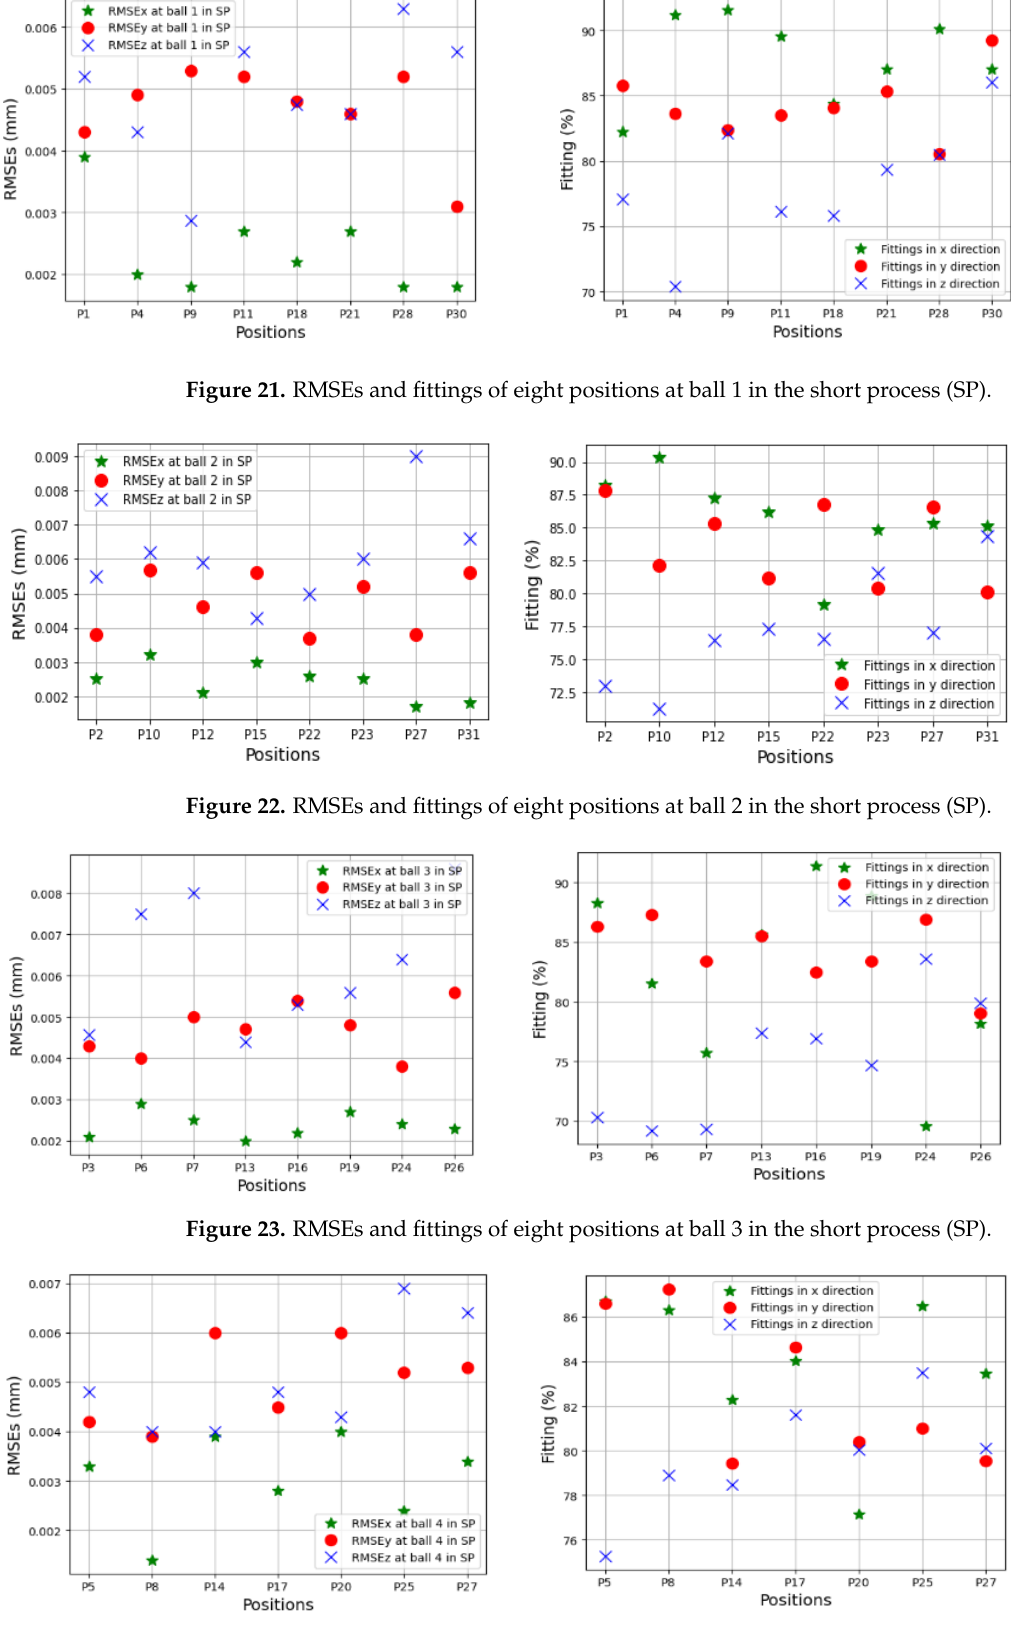
Figure 24. RMSEs and fi tt ings of seven positions at ball 4 in the short process (SP).